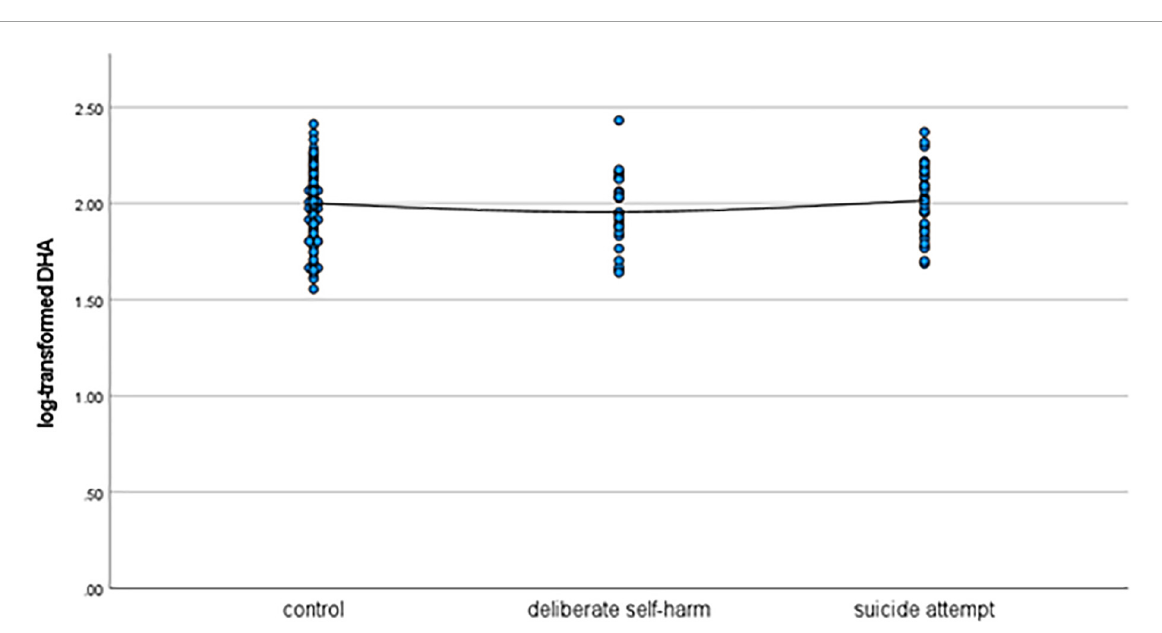
with deliberate self-harm than in control patients, and that the positive association with AA levels and female sex and the negative association with age were significantly larger in patients